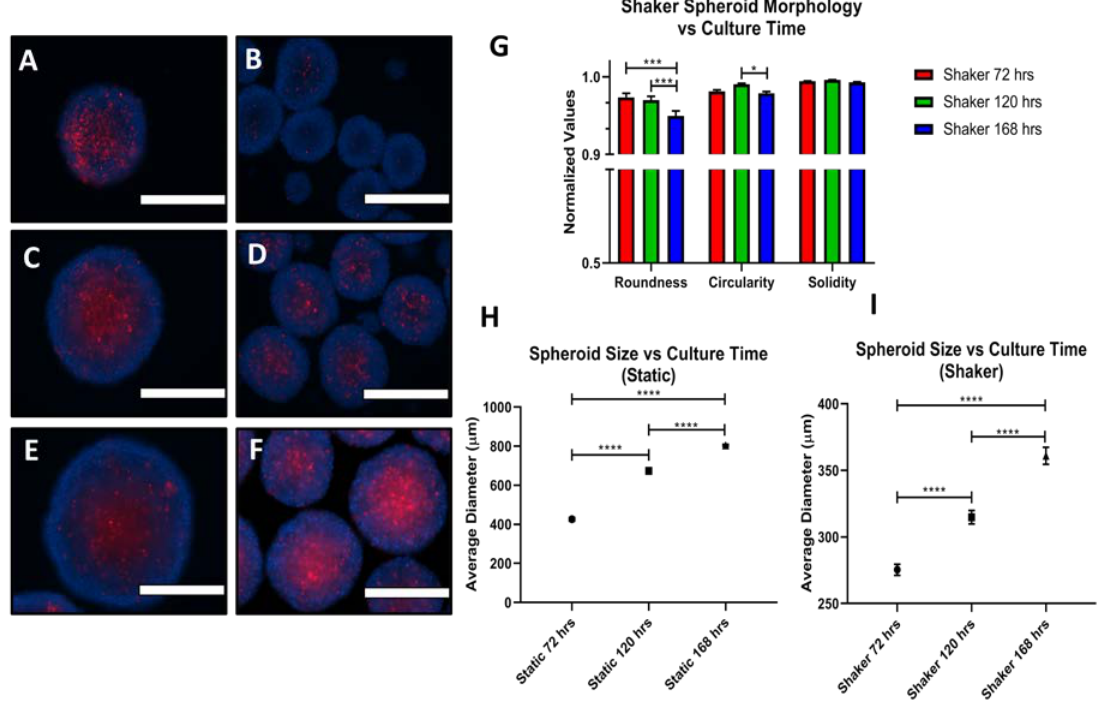
Figure 10. Long-term culture of spheroids on shaker. Propidium iodide (PI) and Hoescht staining was done at 72 ( A , B ), 120 ( C , D ) and 168 ( E , F ) h for static ( A , C , E ) and shaker ( B , D , F ) spheroids. ( G ) RSC values from 72–168 h. ( H , I ) Spheroid size from 72–168 h for static and shaker spheroids, respectively. Scale Bar: 400 µ m. ( n = 3)